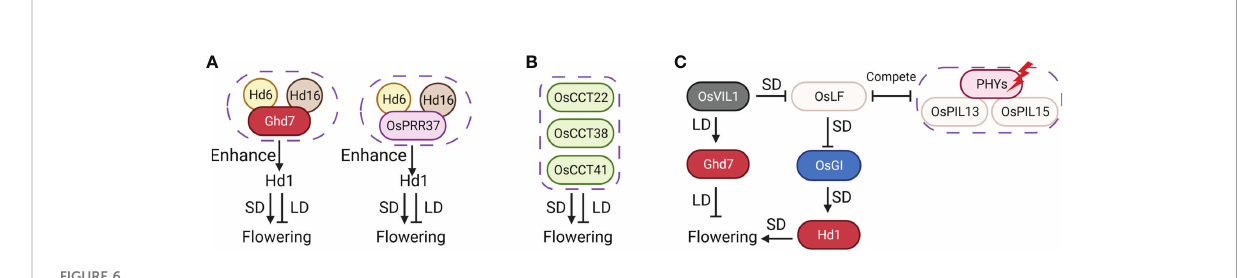
FIGURE 6 Other bifunctional regulators in rice. (A) Hd6 and Hd16 function as enhancers of the bifunctional action of Hd1 , and fi ne-tune the CDL of fl owering. (B) Three new dual-function fl owering regulators in CCT domain-containing protein family. (C) OsVIL1 could activate fl owering by suppressing OsLF under SD and delay fl owering by inducing Ghd7 under LD. Arrows represent positive regulation, inhibitors represent negative regulation, and graphical overlap represents protein physical